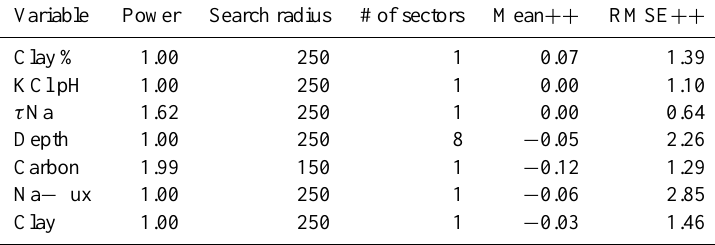
Table 7. IDW of residuals – optimized modeling